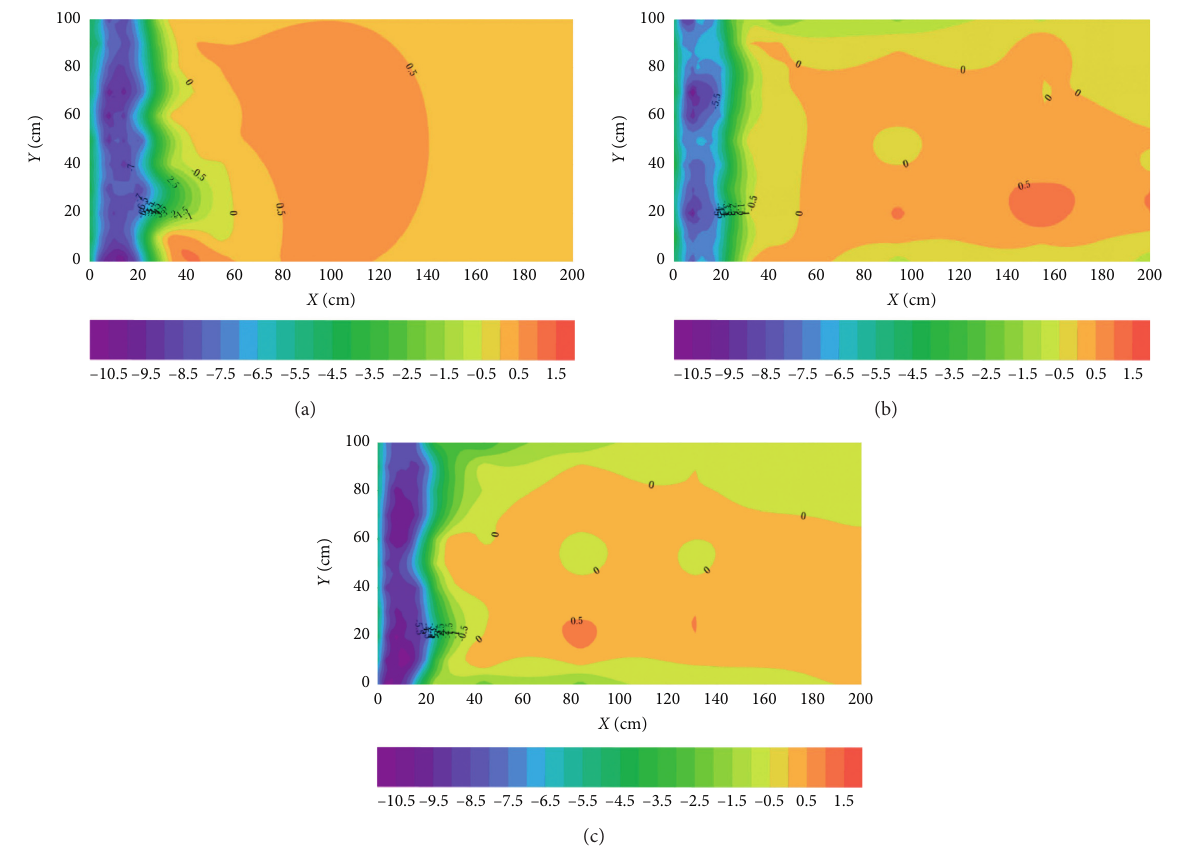
Figure 12: The bed topography of the chute without divergence at a discharge rate of 15.5L/s for (a) standard, (b) semicircular, and (c) trihedral blocks.